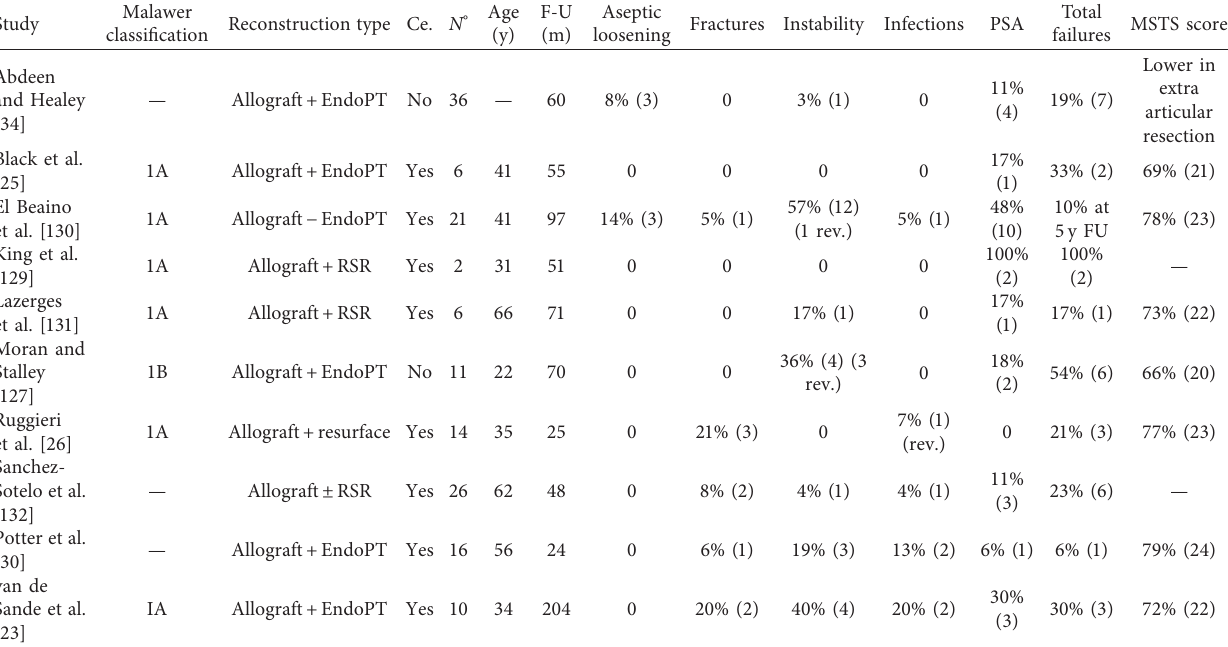
Table 4: Summary data for APC studies.